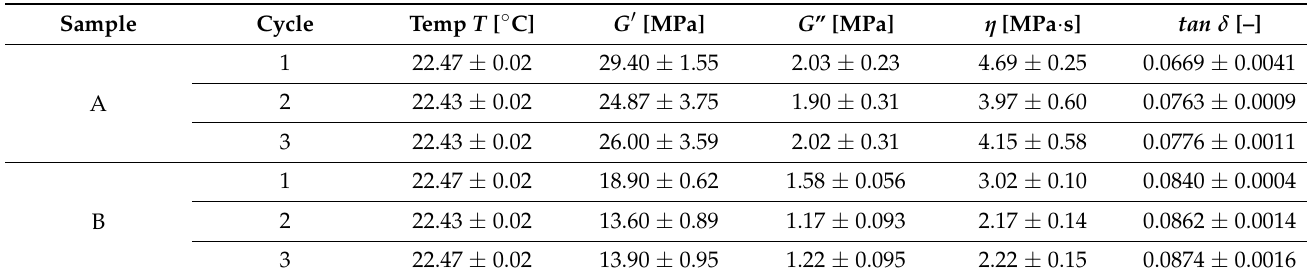
Table 2. Values of: shear storage modulus G (cid:48) , shear loss modulus G (cid:48)(cid:48) , dynamic viscosity η and loss factor tan δ determined at room temperature.